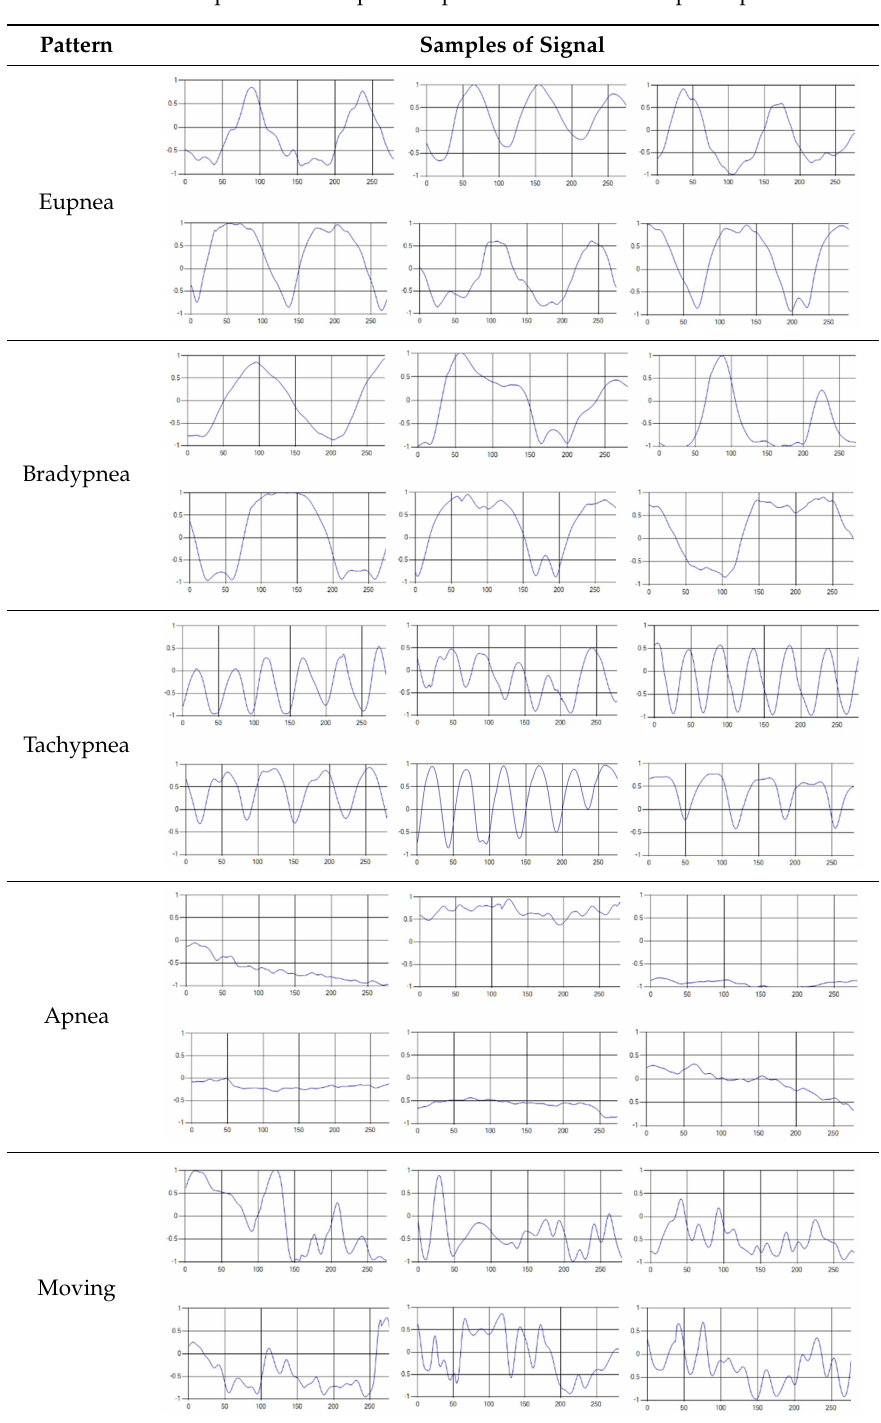
Table 6. Samples of five respiration patterns collected from